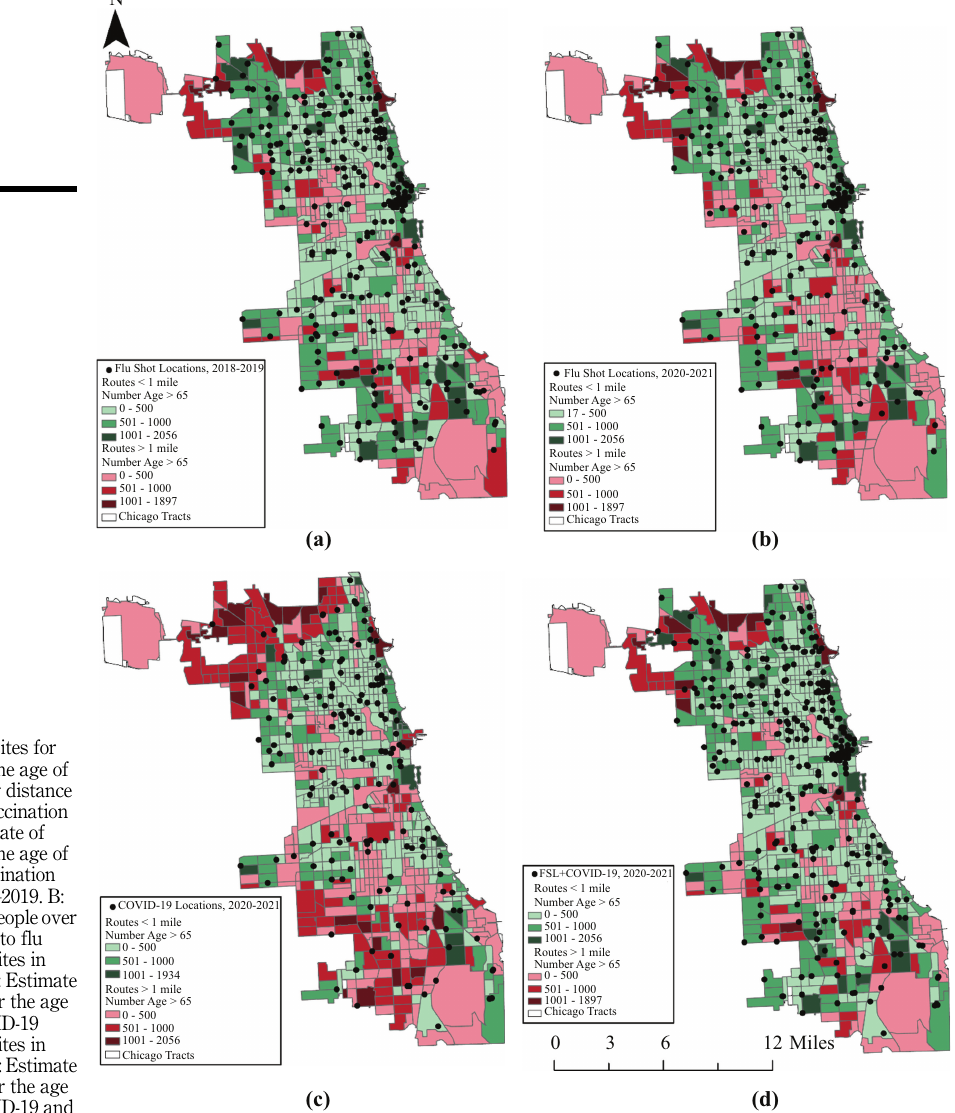
Figure 1. Vaccination sites for people over the age of 65 by driving